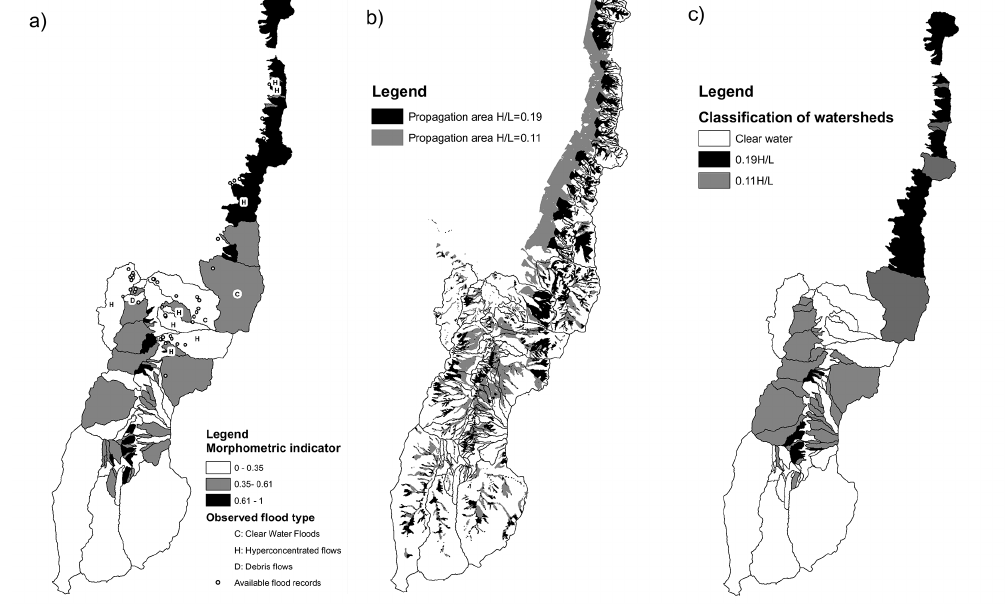
Figure 8. (a) Morhometric indicator, (b) propagation of debris flows, (c) classification of